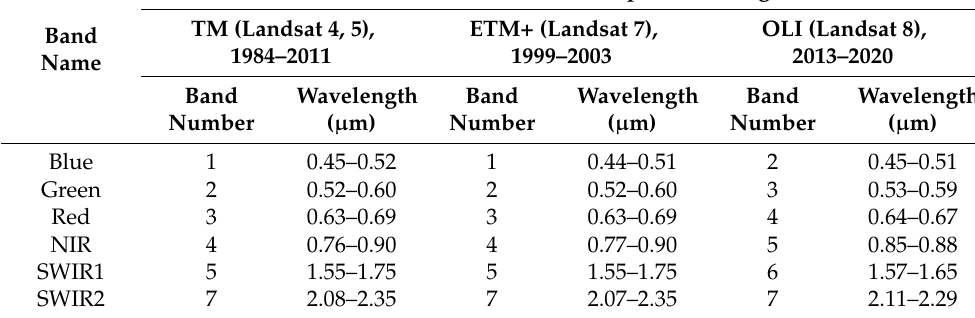
Table 2. Characteristics of utilized spectral bands of Landsat images acquired by different satellite sensors. Sensor (Satellite) and Its Temporal Coverage Band Name